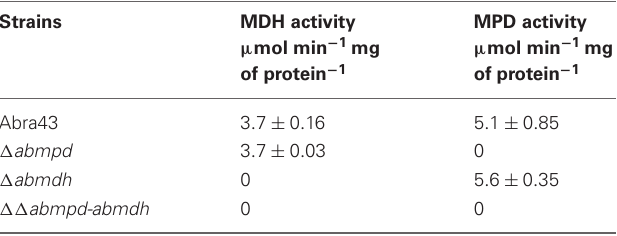
Table 2 | Enzyme activities related to mannitol metabolism in mycelia of Abra43 wild-type and mutant strains.